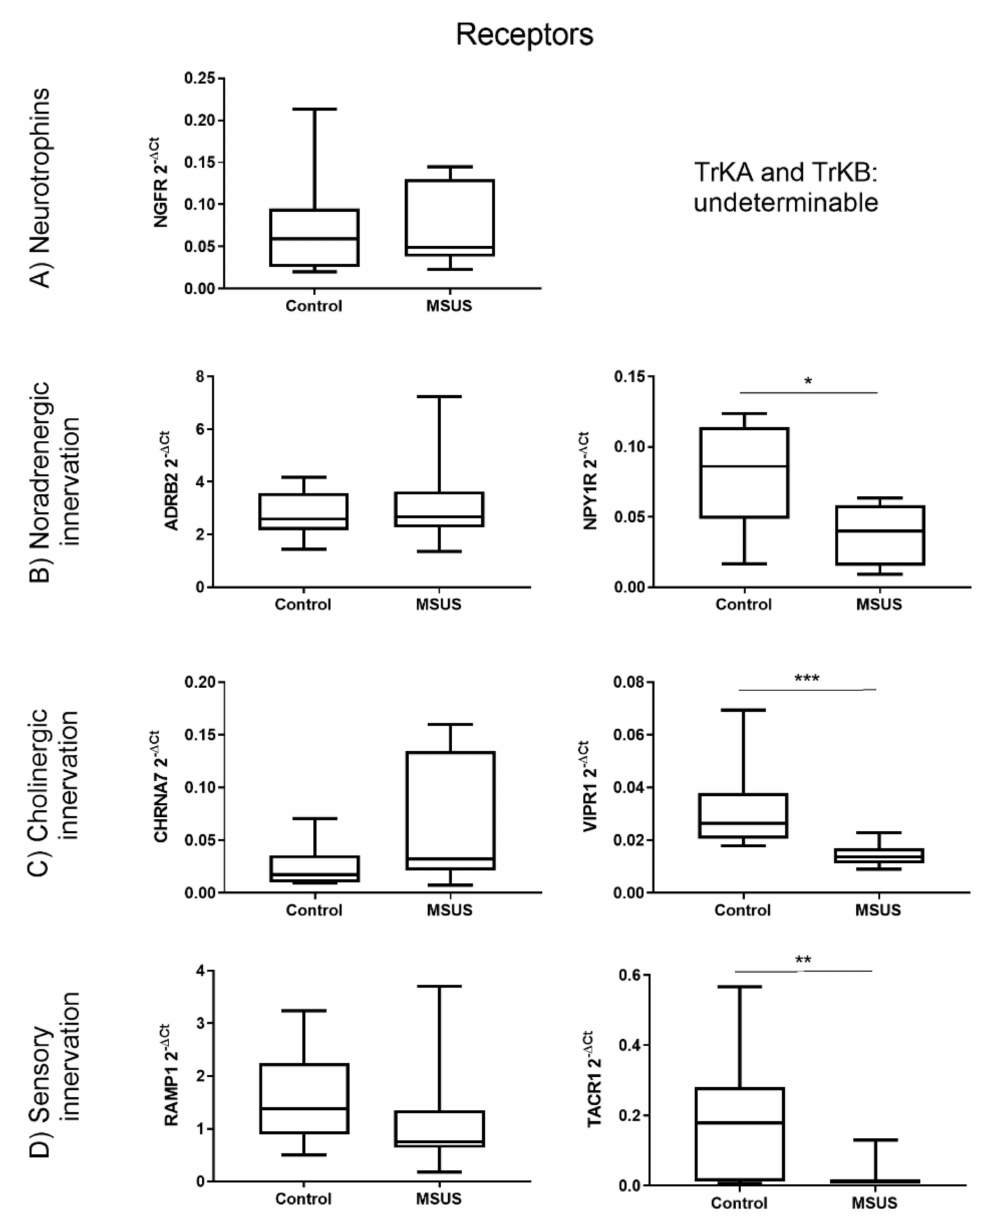
Figure 1. : Di ff erential gene expression of neuronal receptors in bone between control and mice exposed to early life stress (MSUS) mice. Shown are the gene expression of neurotrophin receptors ( A ), noradrenergic receptors ( B ), cholinergic receptors ( C ) and receptors involved in sensory innervation ( D ). Data ( n = 8 per group) are expressed as Min to Max of 2 − dCt . Significance level: *** p < 0.001, ** p < 0.01 and * p < 0.05 between indicated